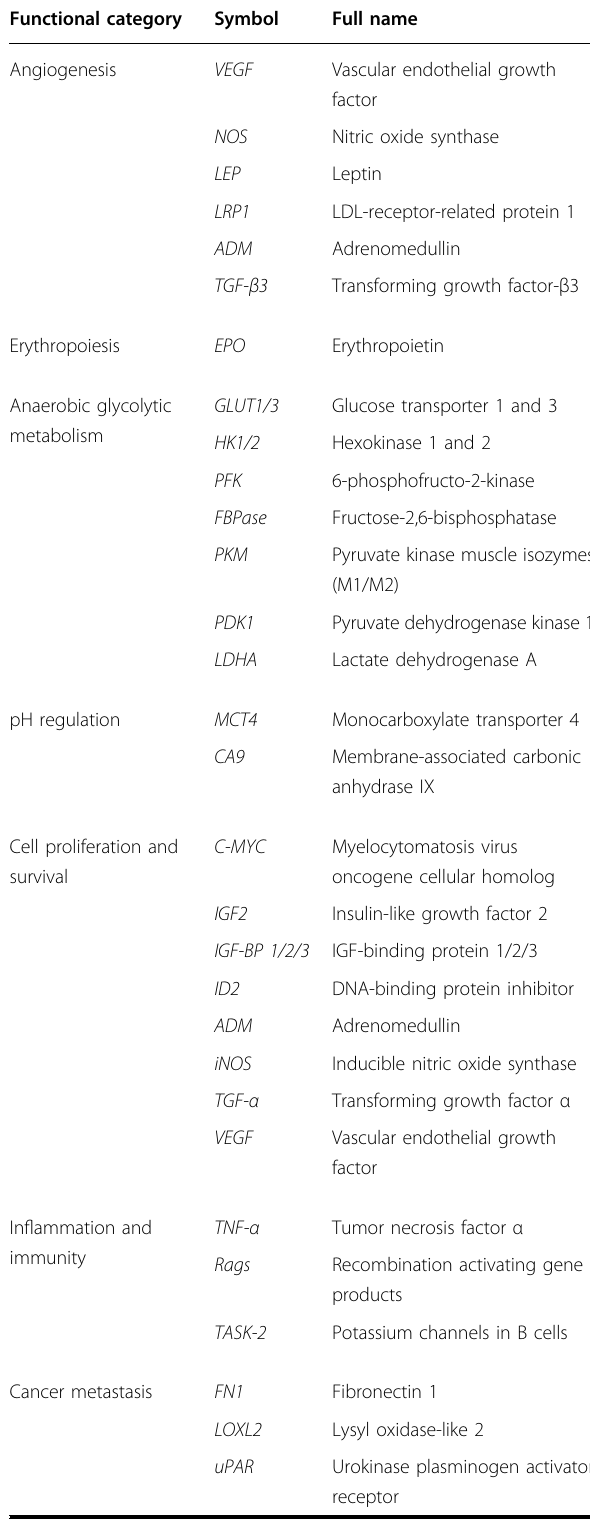
Table 1 Representative HIF-1 target gene products Functional